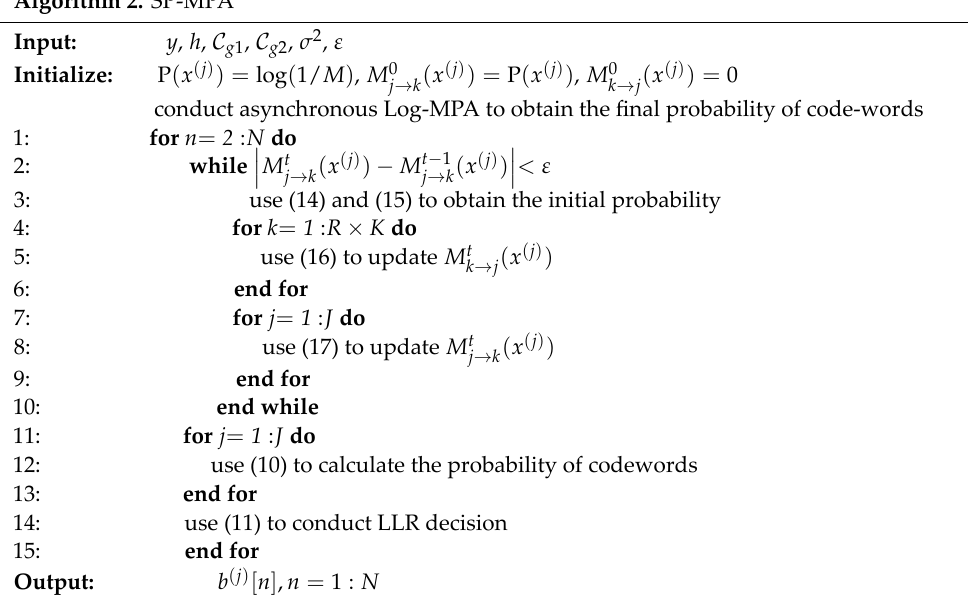
Algorithm 2. SP‑MPA